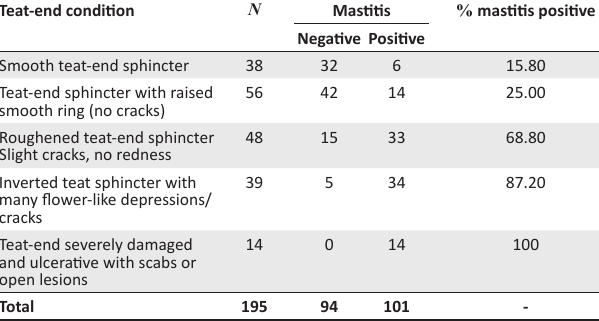
TABLE 3: Prevalence of mastitis with regard to teat-end conditions in examined cows.